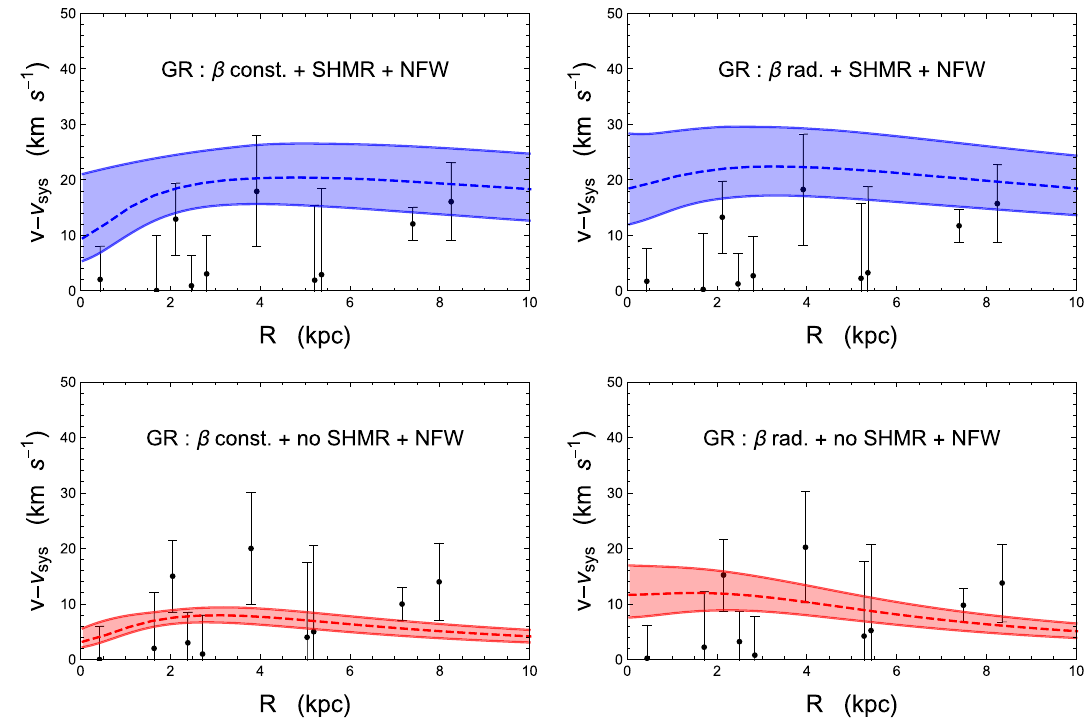
Fig. 2 VelocityoffsetprofilesofNGC1052-DF2withGRandagNFW DM component. Black dots and bars are observational data, v i − v sys , with uncertainties, σ v . Colored dashed line and shaded regions are i respectively the median and the 1 σ confidence region of the σ los profile